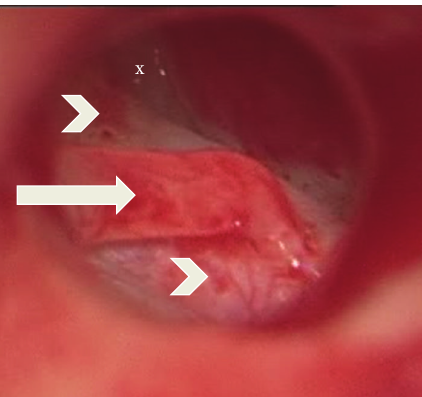
Figure 1: Right exploratory tympanotomy showing the incus (arrow) resting over the facial nerve (arrowhead), a hypoplastic oval window (x), and the complete absence of the stapes superstructure.